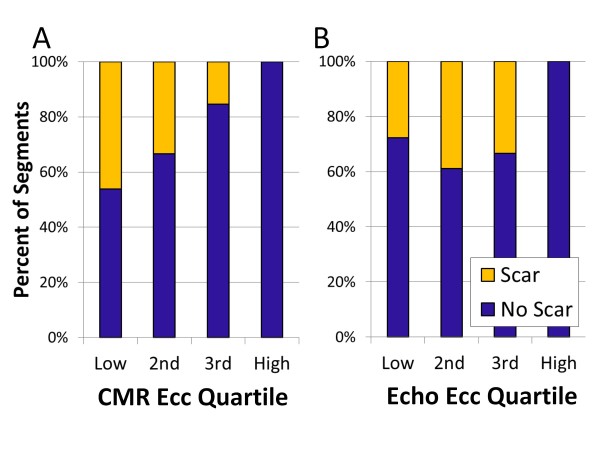
Segmental scar and circumferential strain by CMR versus VVI echocardiography. The distribution of myocardial fibrosis by quartile of Ecc as assessed with (A) CMR (all segments) or (B) VVI echocardiography (mid-cavity segments only) is shown. A) No segments with Ecc by CMR in the fourth (most negative) quartile had myocardial scar. Myocardial scar was most common in the two lowest (most dysfunctional) Ecc quartiles. B) Scar was also unlikely in segments falling into the fourth quartile of Ecc as assessed by echo VVI and was distributed in the lower three echo Ecc quartiles. 1st quartile = least negative Ecc (most dysfunctional); 4th quartile = most negative Ecc.